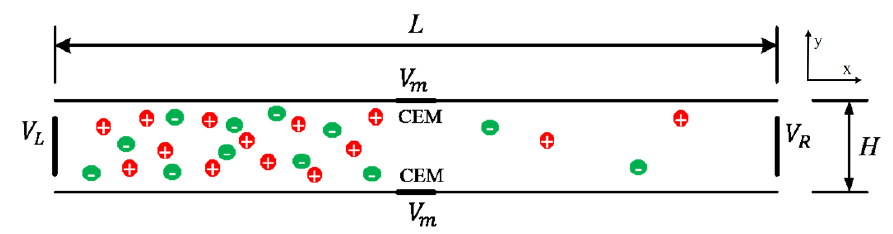
Figure 1. Schematic diagram of the microchannel model embedded with an ion exchange membrane IEM.